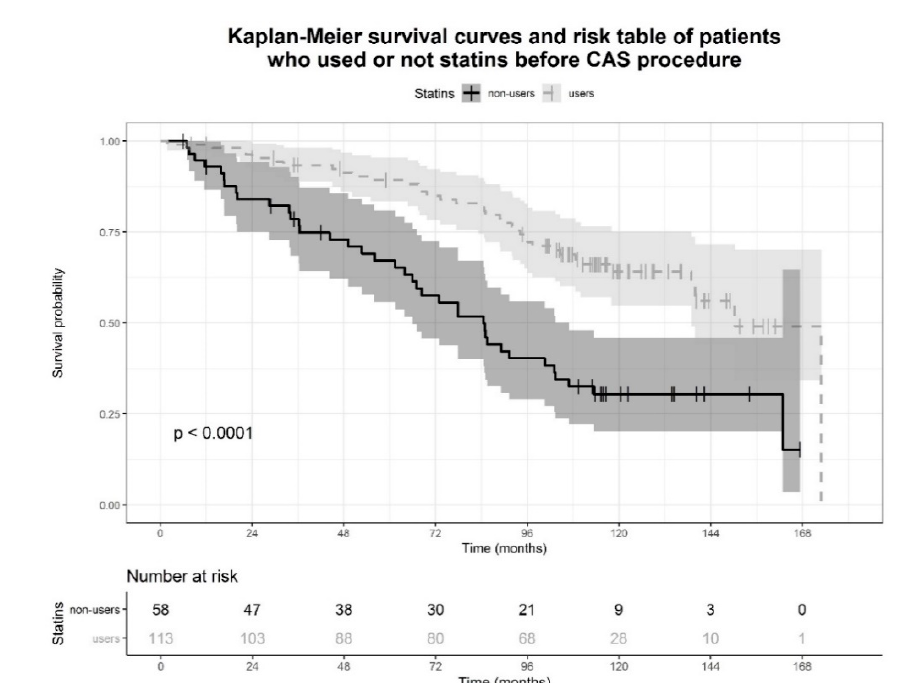
Figure 3. Kaplan-Meier survival curves with 95% confidence intervals and risk table of patients stratified in statin users and not-users. Vertical lines represent censored patients. Probability of the log-rank statistic, p , is reported.